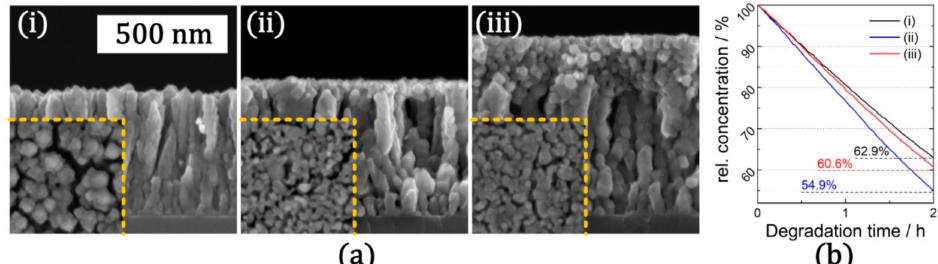
Figure 8. Surface decoration of TiO 2 thin film (with nanocracks) by TiO 2 NPs fabricated by